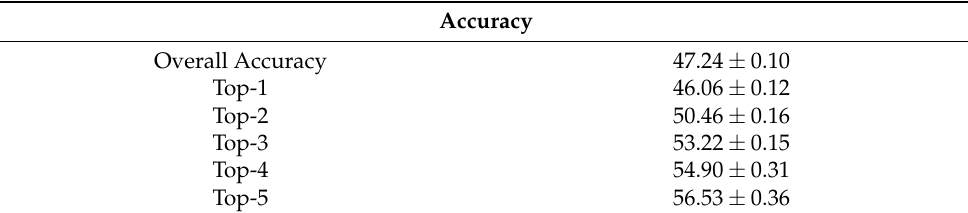
Table 4. The accuracy of the proposed system on the second session.